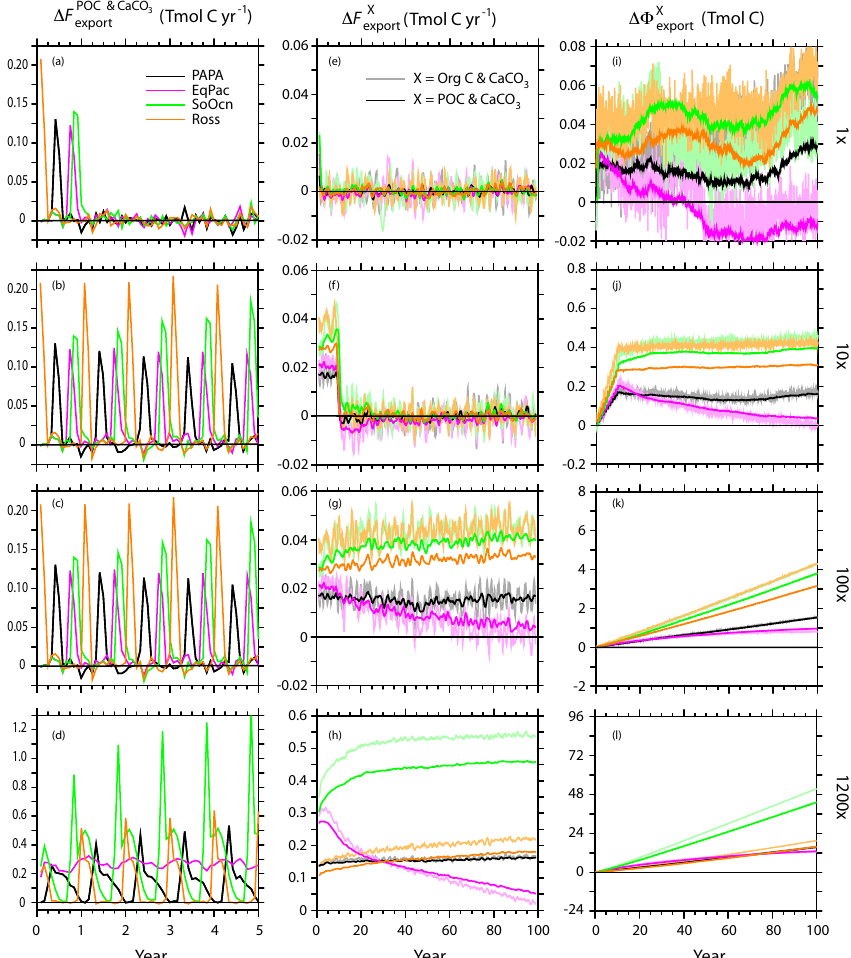
Fig. 5. (a–d) show the perturbation response of the monthly particulate organic carbon (POC) and CaCO 3 export production 1F POC & CaCO 3 export over the first 5 years for better resolution (see Appendix A for a definition of 1F POC & CaCO 3 export and related terms). (e–h) show the monthly carbon export 1F X export over the first 100 years. The light colored lines show total carbon, X = Org C & CaCO 3 , and the dark colored lines show only the particulate component of organic carbon, X =POC & CaCO 3 . (i–l) show the cumulative export of carbon 18 X export , with X as above. We define export as the net downward flux across a depth of 98 m. The rows correspond to the 1x, 10x, 100x, and 1200x cases from top to bottom. The flux of dissolved and living organic matter in the Org C component is very noisy, and the total carbon export fluxes in the middle and right hand column were heavily smoothed twice with a 12-month boxcar filter in order to make the different results distinguishable. Note that the POC & CaCO 3 export component accounts for most of the export flux at PAPA and the Equatorial Pacific sites, but misses a significant component of the total carbon export at the other two sites. 1200x case showing approximately 12 times the response of the 100x case. (Note that the vertical axes of Fig. 5i to l are scaled according to the total amount of iron added.)